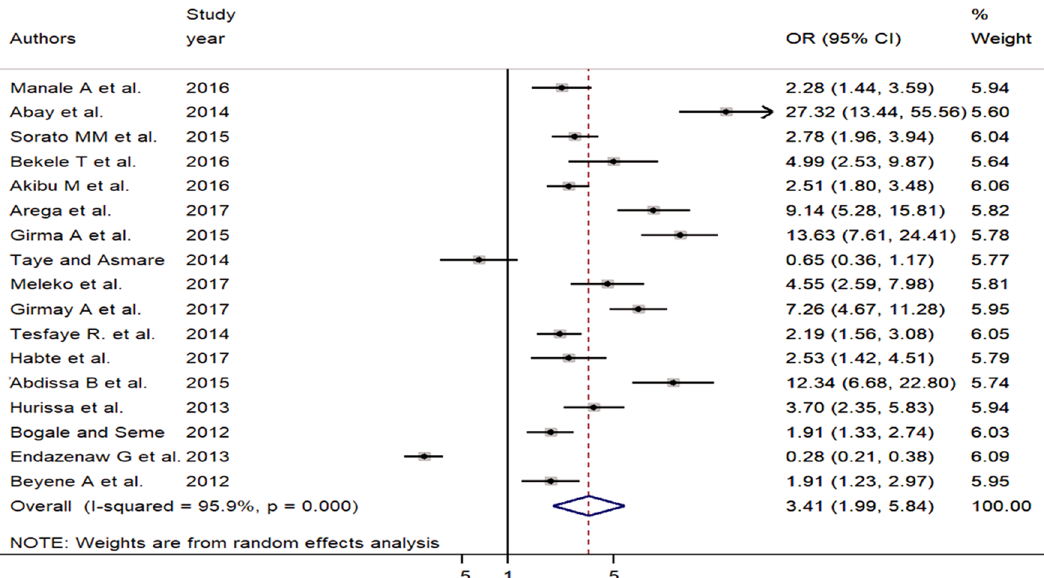
Figure 5. Forest plot of the association between premarital sexual practice and watching pornography among students in Ethiopia, 2021.